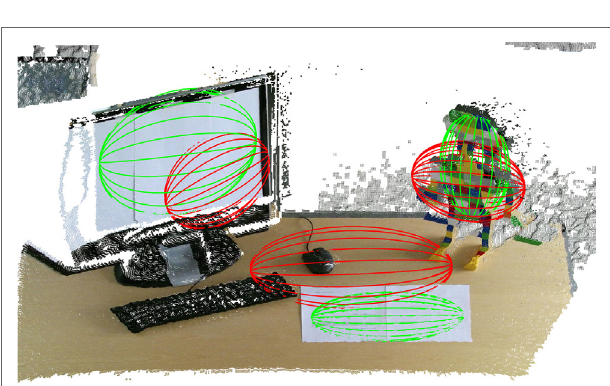
FigUre 6 | Representation of the estimated components of the GMM (ellipsoids in red) and the ground truth normal distributions N i,truth (ellipsoids in green), overlapped with the point cloud.